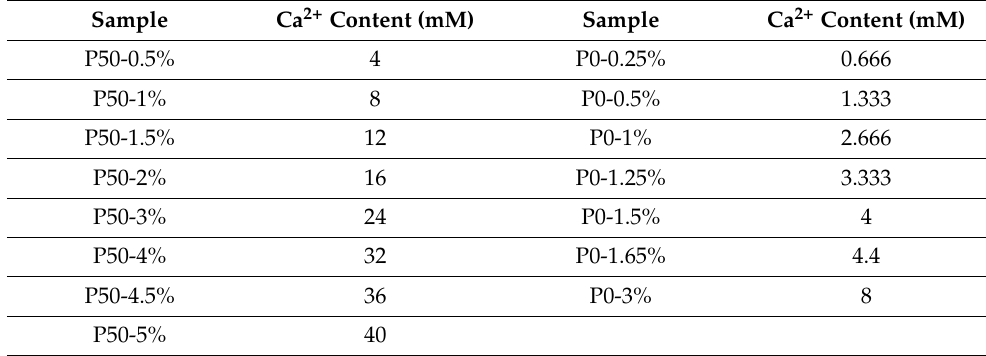
Table 2. Ca 2+ content in the gel initiator